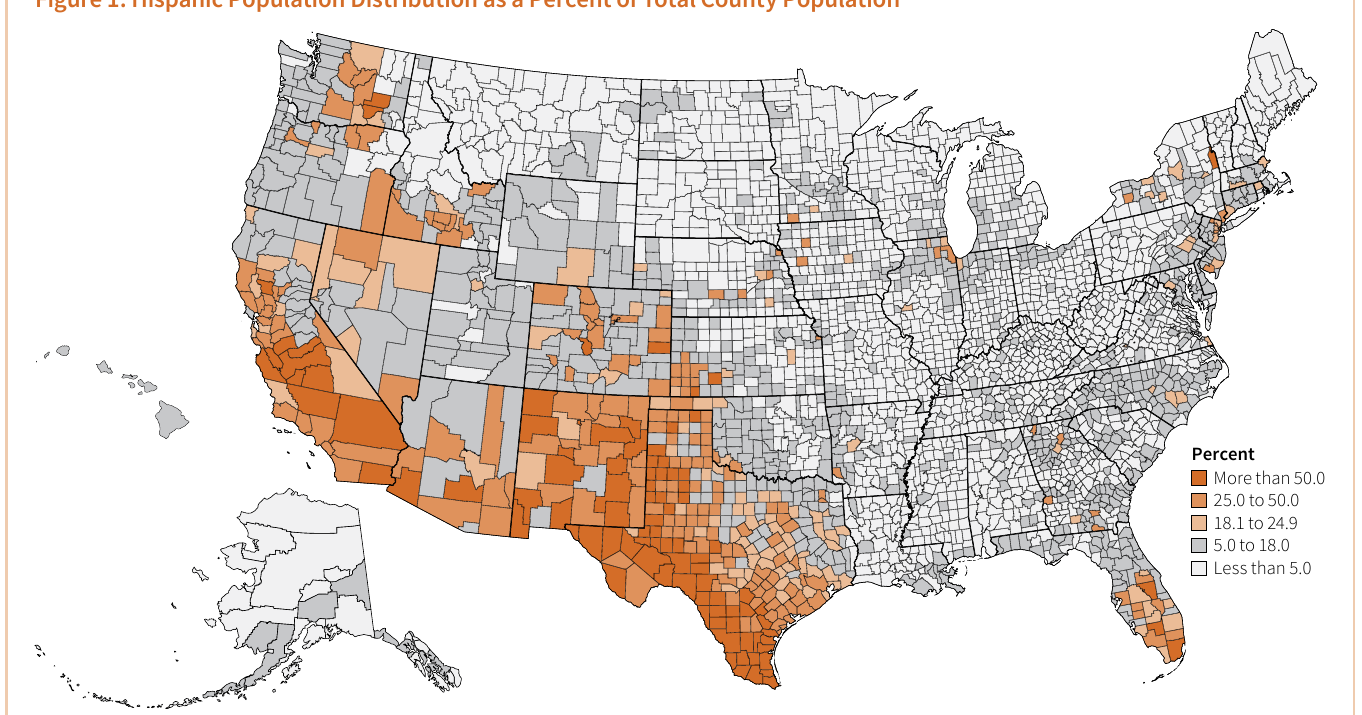
Figure 1. Hispanic Population Distribution as a Percent of Total County